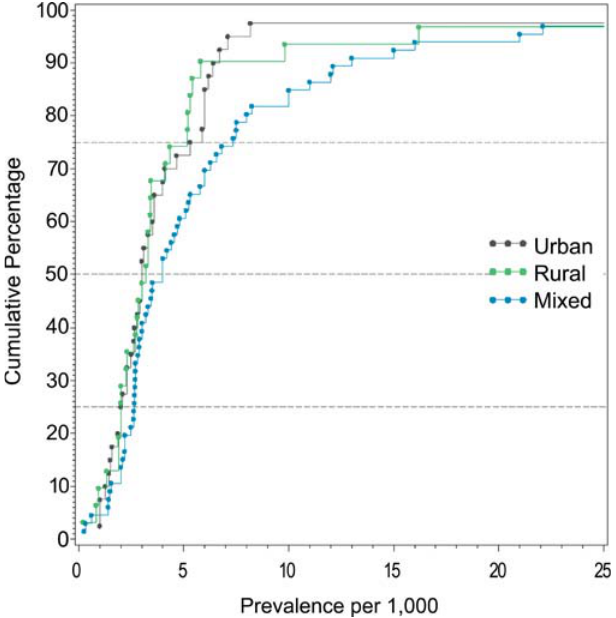
Figure 11. Cumulative Plots of the Migrant:Native-Born Prevalence Estimate Ratio for Persons DOI: 10.1371/journal.pmed.0020141.g011